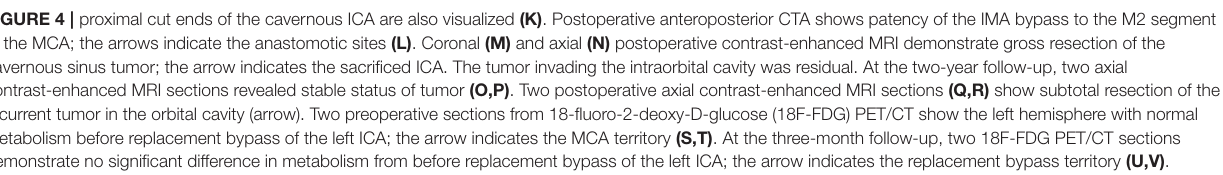
occlusion of the ICA during middle cranial fossa tumor